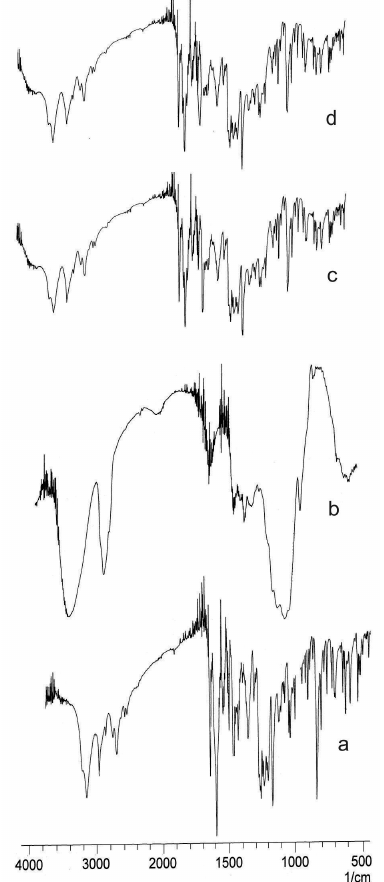
( a ) Raloxifene HCl, ( b ) HPMC E5 LV ( c ) Physical mixture (d) Solid dispersions prepared by the microwave induced fusion method with an exposure time of 6 min.